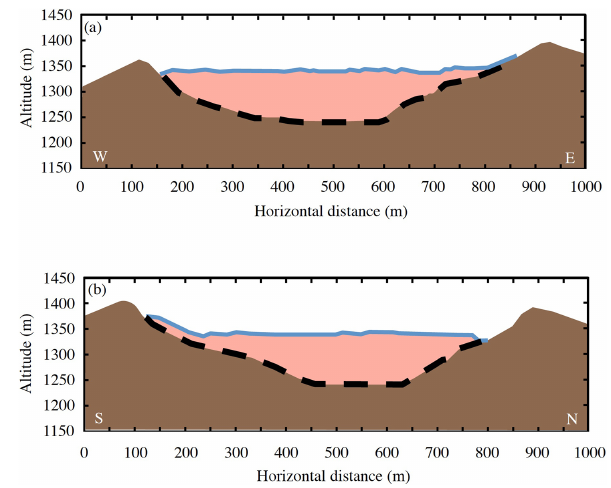
Figure 6. Caldera deformation captured with airborne synthetic aperture radar (SAR) measurements. The black dotted and blue solid lines, respectively, show the topography of the caldera floor before (March 2009) and after (February 2011) the 2011 eruption for the west–east cross section (a) and south–north cross section (b) .